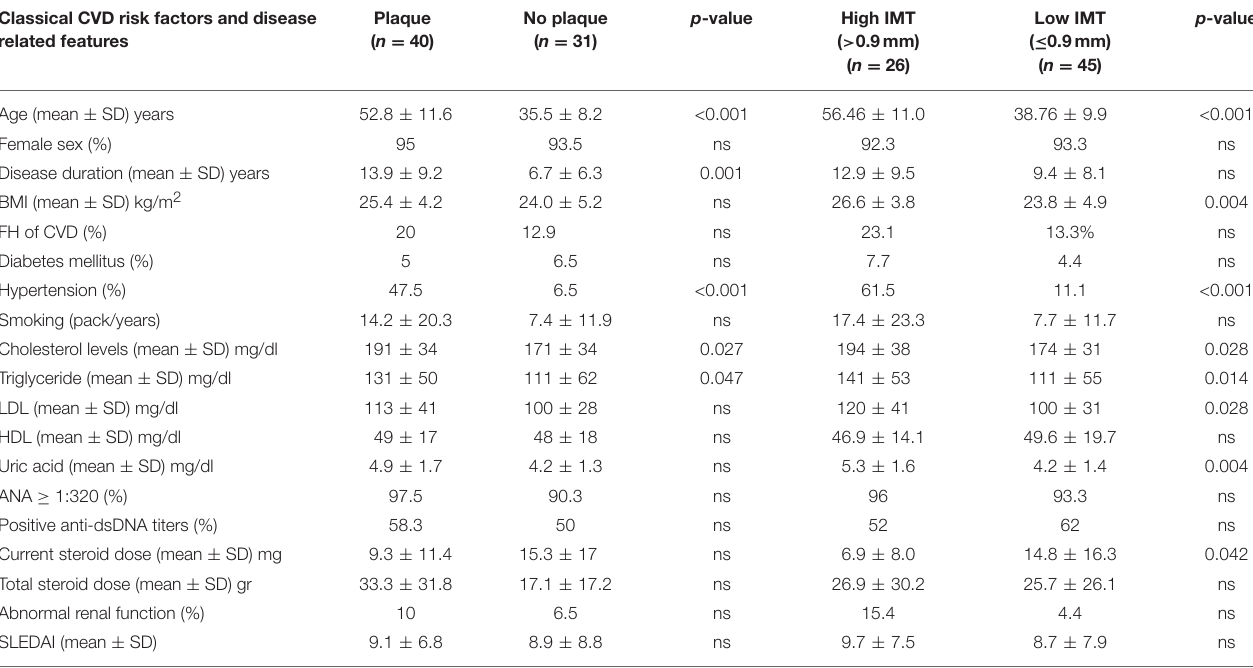
TABLE 1 | Traditional and disease related predictors of carotid/femoral plaque and arterial wall thickening (defined as IMT scores > 0.90mm) in 71 patients with SLE included in the study. Classical CVD risk factors and disease related features